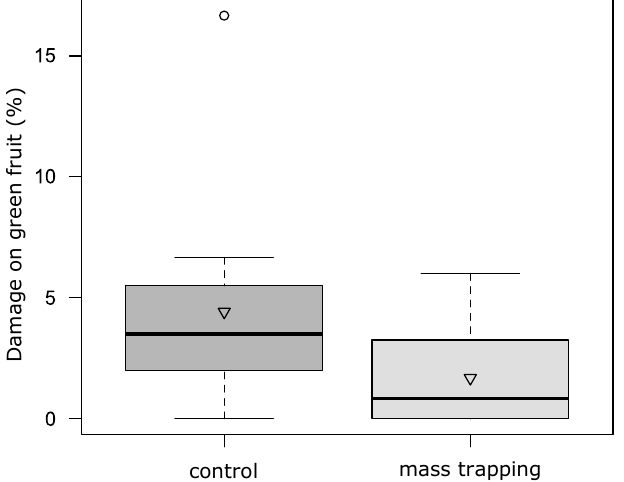
Figure 7. Damage on small green strawberry fruit in control and mass trapping plots ( n = 12). The boxes enclose the first and third quartiles; the ends of the whiskers represent the 5th/95th percentiles, the solid lines the median and the triangle the mean.